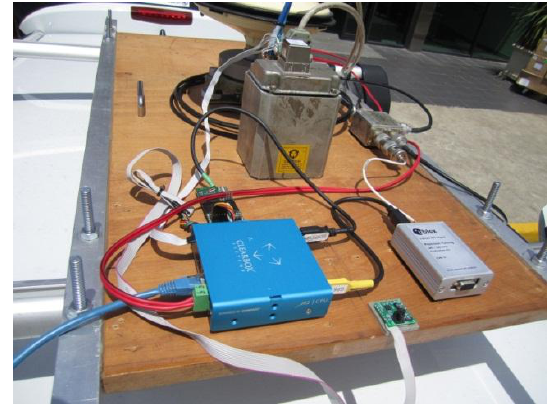
Figure 2 - Navigation system mounted on roof of car.